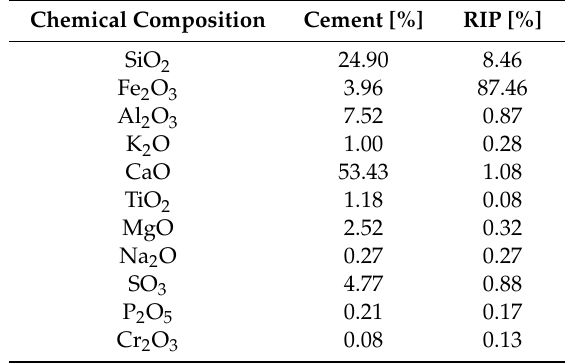
Table 2. Chemical compositions of cement and recycled iron